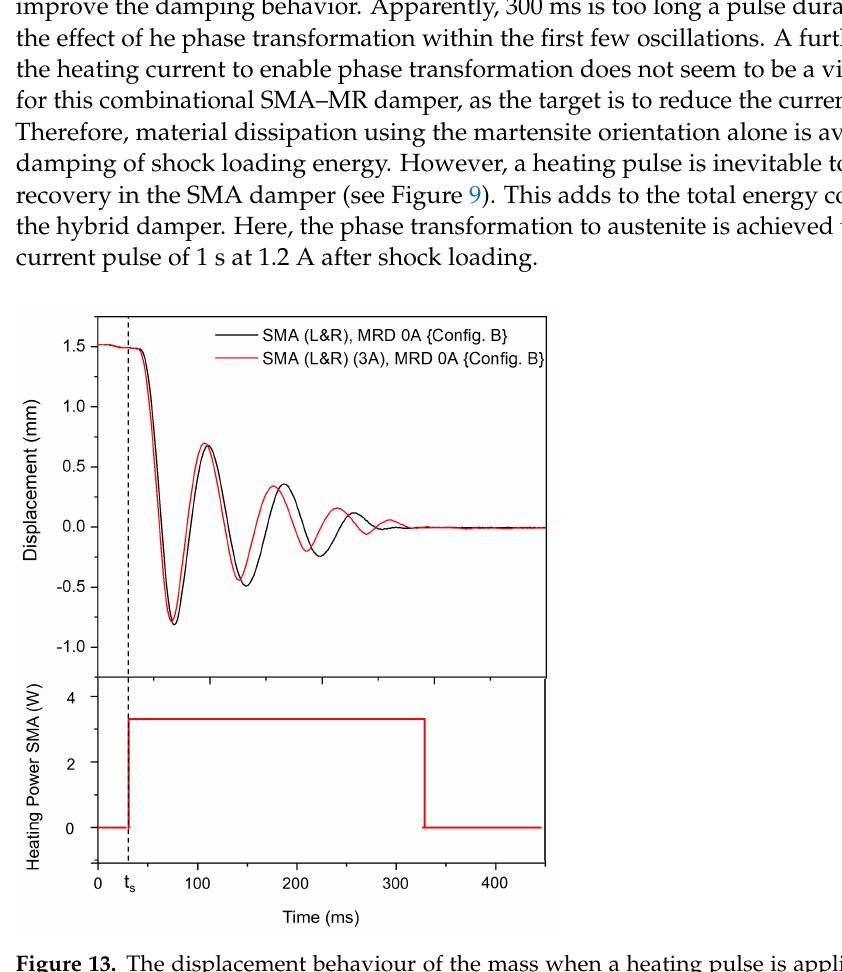
Figure 13. The displacement behaviour of the mass when a heating pulse is applied on the SMA